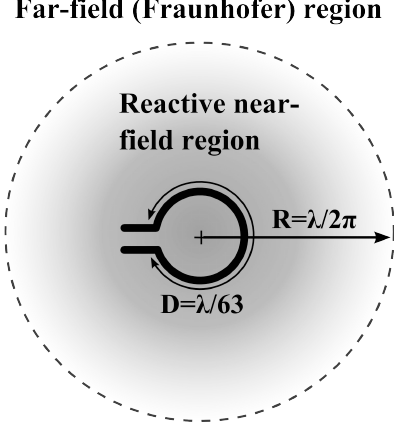
Figure 2. Antenna near- and far-field